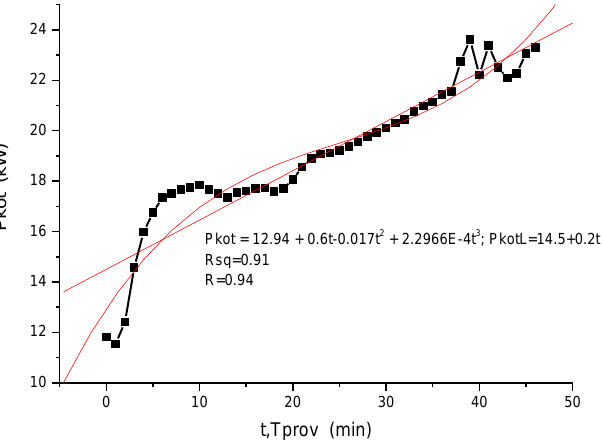
Figure 13. Dependence of Pkot on operation time.